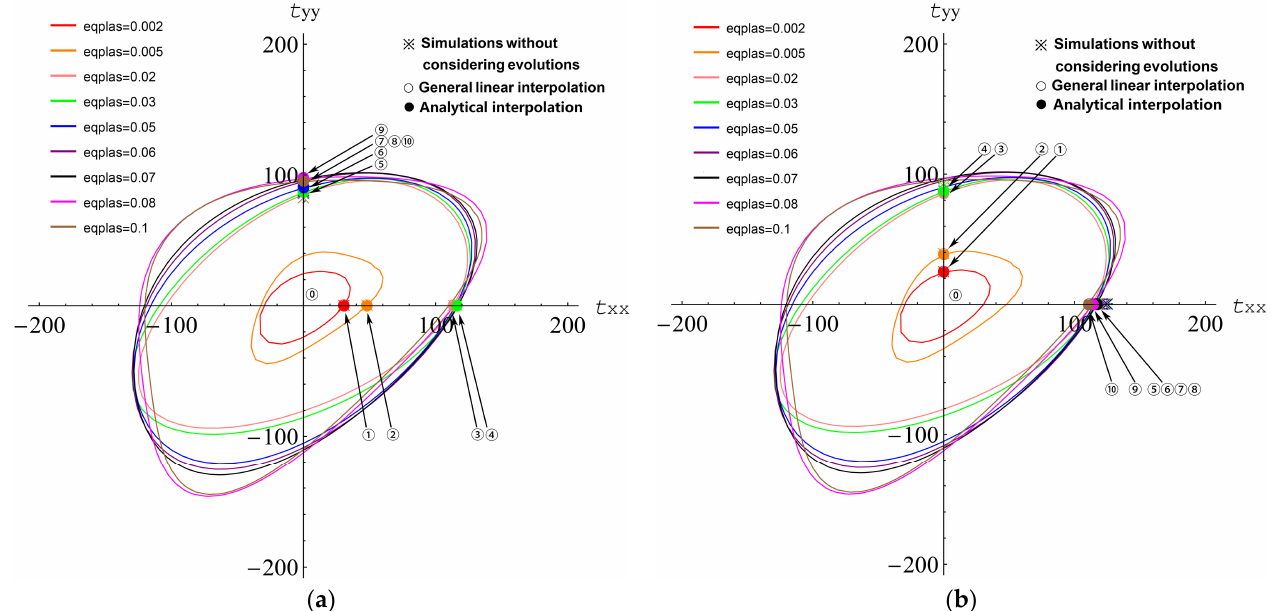
Figure 9. Orthogonal loading for continuous large deformation of ZK60 magnesium alloy: ( a ) X uniaxial tension-Y uniaxial tension and ( b ) Y uniaxial tension-X uniaxial tension.